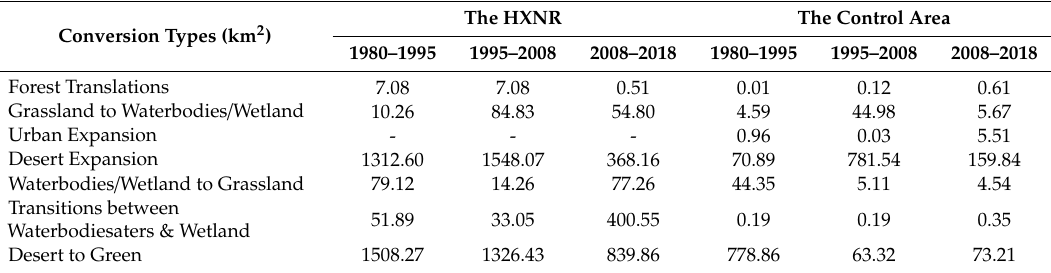
Table 4. Land use / land cover conversions in the study area for di ff erent periods before and after the establishment of the HXNR.